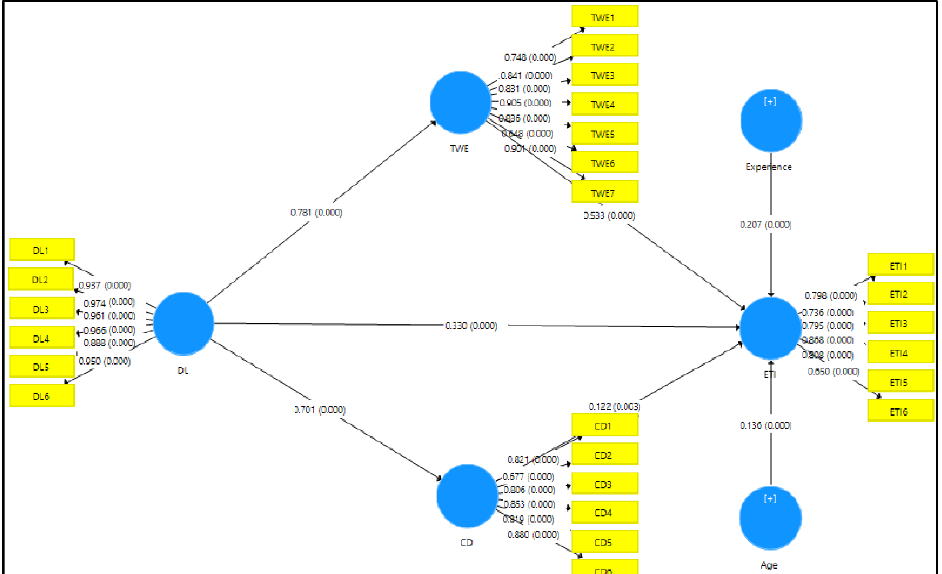
Figure 2. Research output model (structural relations among variables).